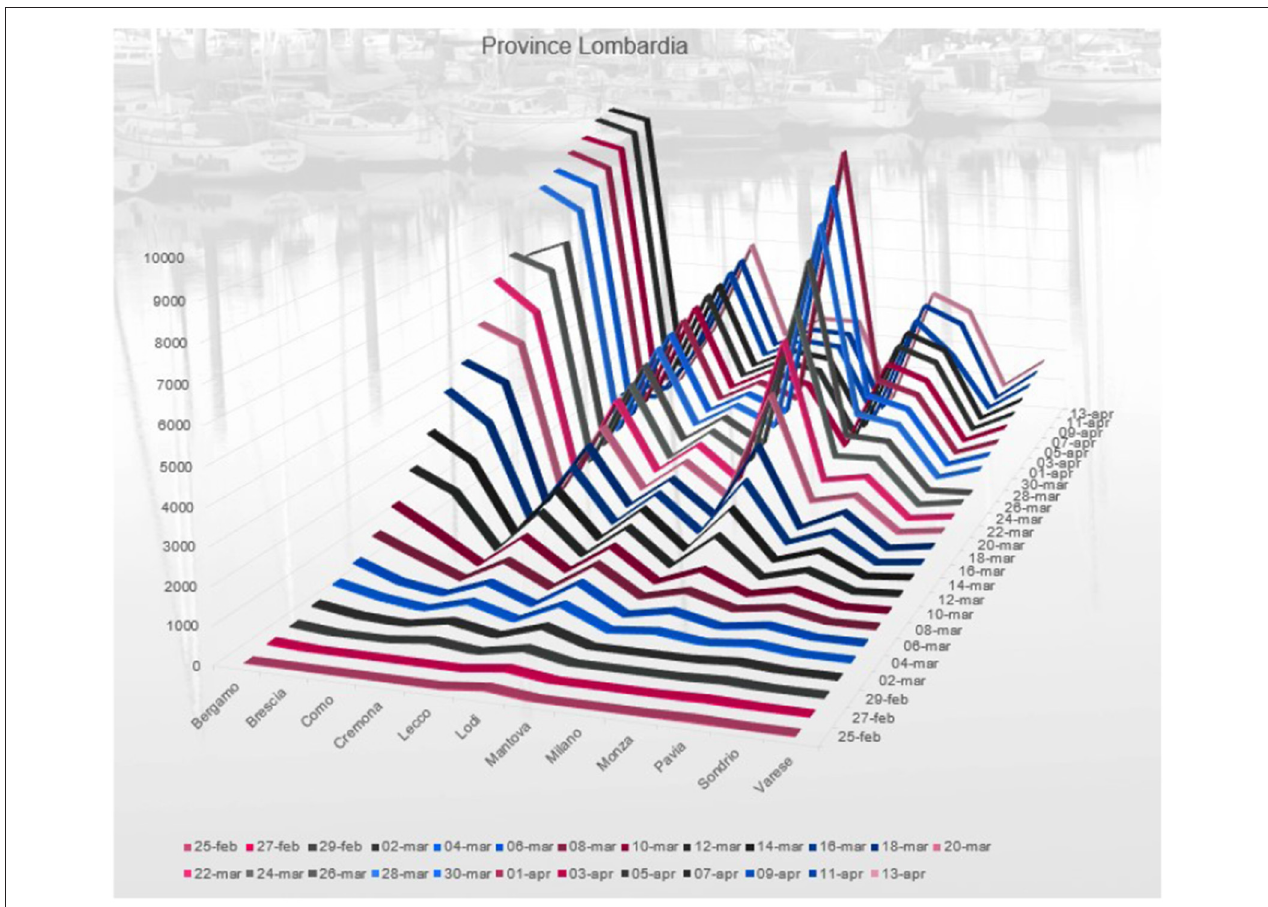
FIGURE 8 | An example of homework submitted by a